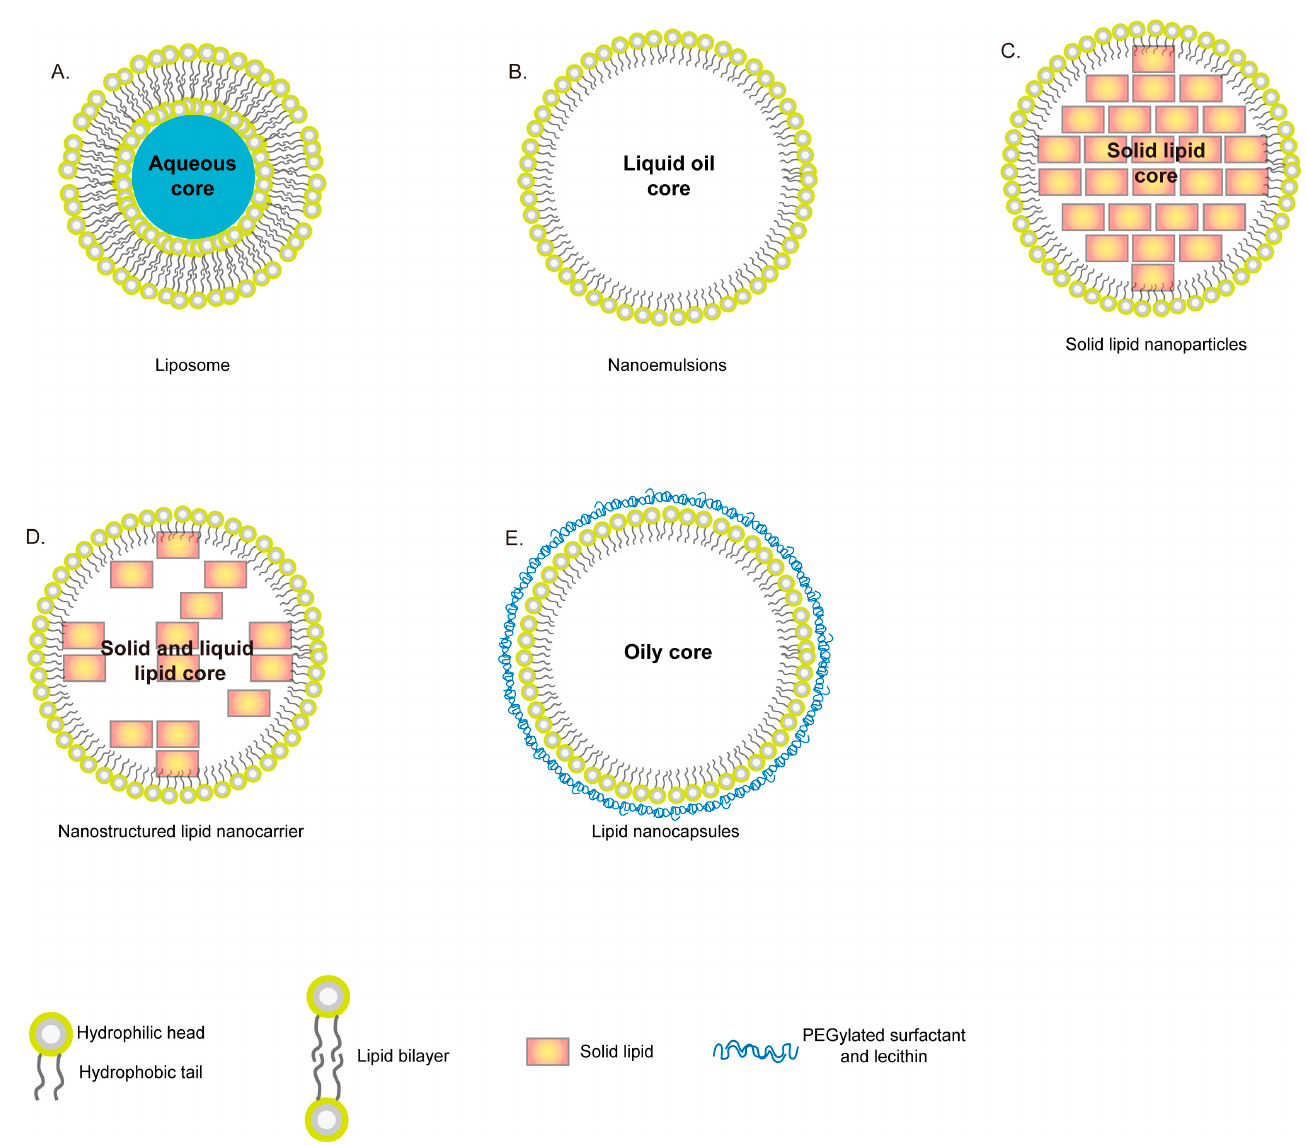
Figure 2. Schematic representation of lipid-based nanosystems. ( A ) Liposomes are developed as double-layer lipid systems that consist of phospholipid layers and aqueous core. ( B ) Nanoemulsions (NEs) are dispersed nanosystems that consist of a single layer of phospholipid and two types of core, either oil-in-water or water-in-oil. This system is always stabilized with an appropriate surfactant. The size of NEs is typically smaller than 500 nm. ( C ) Solid Lipid Nanoparticle (SLNs) with submicron sizes that range from 50 to 100 nm. SLNs are similar to NEs, but SLNs contain the solid lipid core that offers the enhanced drug release control and system stability. ( D ) Nanostructured Lipid Carriers (NLCs) are considered the second generation of SLN, which contain a hydrophobic nucleus dispersed in an aqueous environment and stabilized by surfactant molecules. It contains both a liquid and solid lipid core that facilitate drug release control and reduce drug expulsion during development and storage. ( E ) Lipid Nanocapsules (LNCs) were the newest developed particles ranging from 20 to 100 nm, and consist of an oily nucleus of medium-chain of triglycerides and are surrounded by a shell of PEGylated surfactant and lecithin.